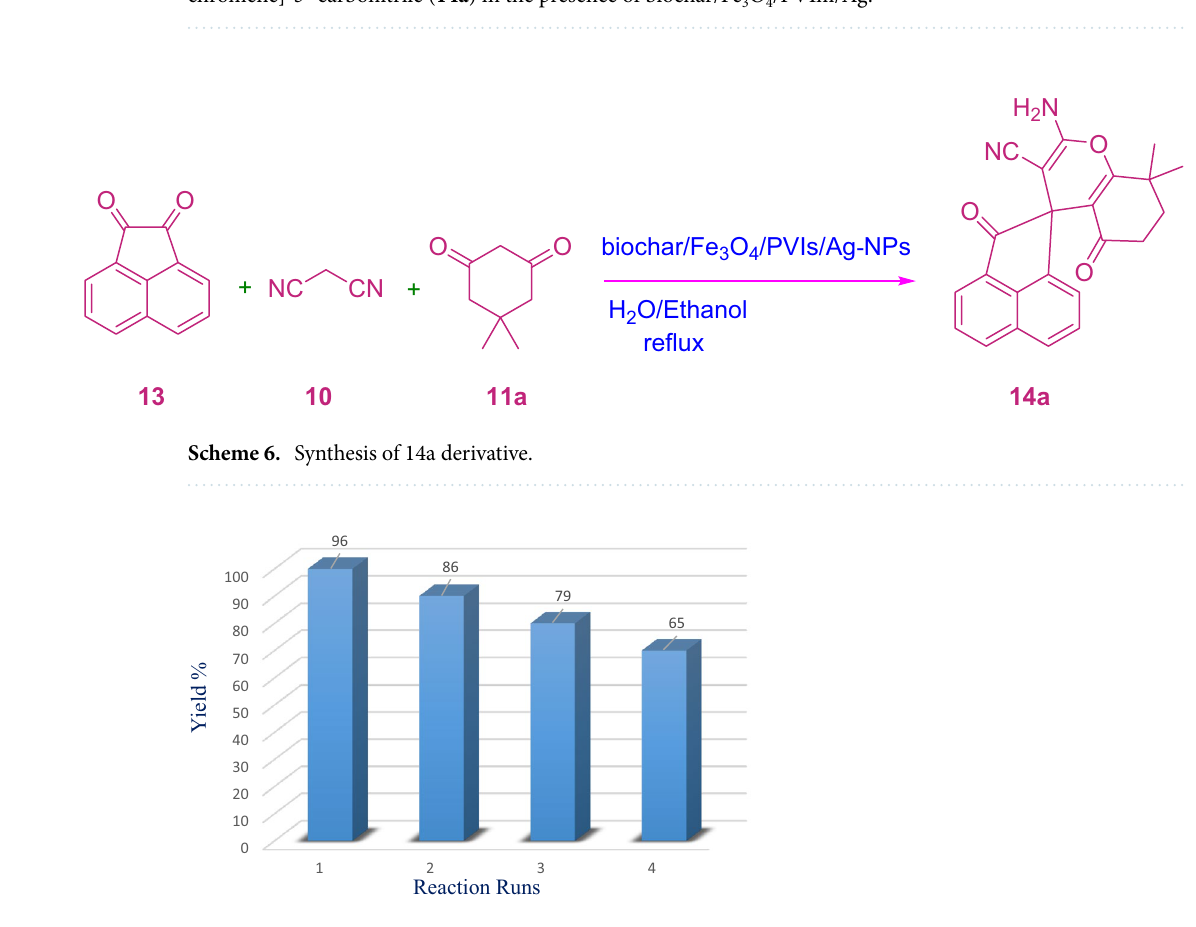
Table 4. Synthesis of 2 ′ -amino-8 ′ ,8 ′ -dimethyl-2,5 ′ -dioxo-5 ′ ,6 ′ ,7 ′ ,8 ′ -tetrahydro-2 H -spiro[acenaphthylene-1,4 ′ - chromene]-3 ′ -carbonitrile ( 14a ) in the presence of biochar/Fe 3 O 4 /PVIm/Ag.